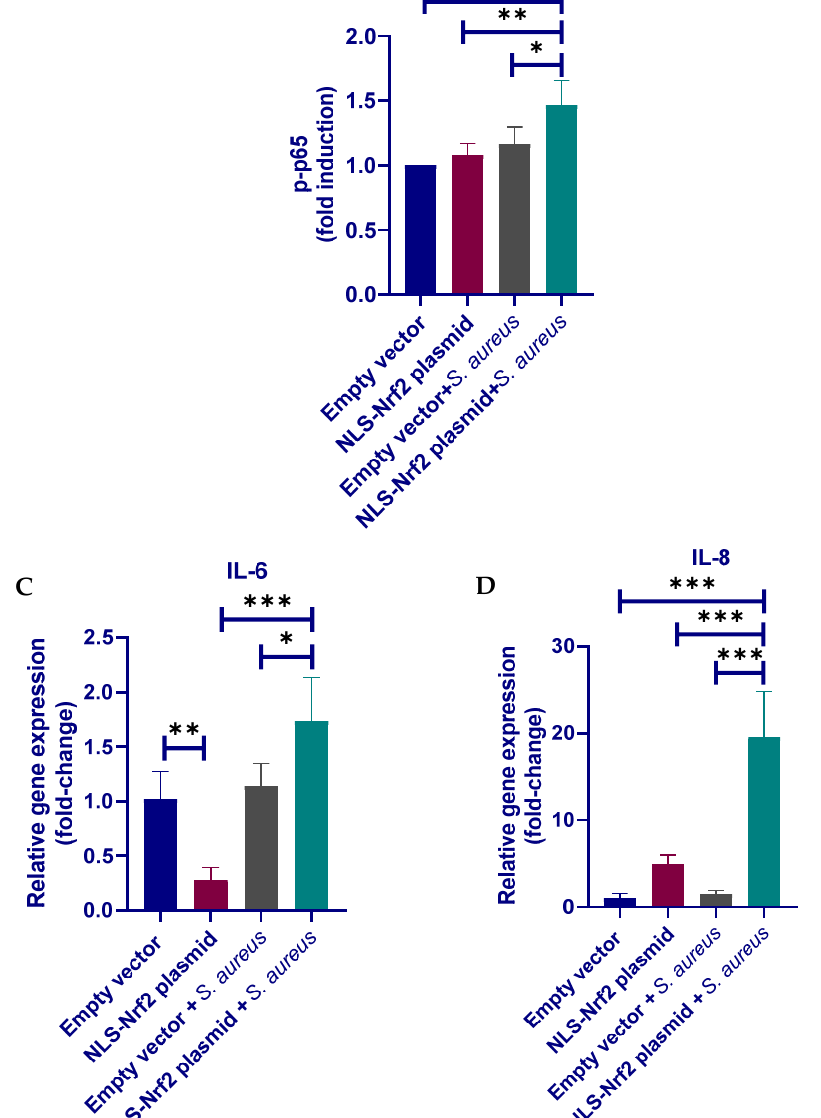
Figure 7. Evaluation of Nrf2 overexpression on the inflammatory responses of pbMECs to S. aureus . ( A ) Confirmation of Nrf2 overexpression. Cells were transfected with a GFP-expressing Nrf2 plasmid containing tripartite nuclear localization signal (NLS-Nrf2) for 24 h. GFP fluorescence was determined under a microscope and whole-cell extracts were analyzed by immunoblotting with anti-GFP. ( B ) Evaluation of the effect of Nrf2 overexpression on NF- κ B p65 activation in response to S. aureus . The cells transfected with GFP-expressing Nrf2 plasmid were incubated with S. aureus for 6 h. Whole-cell extracts were analyzed by immunoblotting with anti-phospho NF- κ B p65 antibody (p-p65). β -actin was used for the equal loading control. p-p65 levels were determined with densitometry analyses after normalization to Actin. Bars are means ± s.d. of three triplicates and are representative of 3 separate experiments. ( C , D ) Evaluation of the effect of Nrf2 overexpression on the expression of pro-inflammatory cytokines was induced by S. aureus . The cells transfected with GFP-expressing Nrf2 plasmid were incubated with S. aureus for 6 h. Total RNAs were prepared and subjected to qPCR analyses for the mRNA levels of IL-6 and IL-8 . The results are the mean ± s.d. of three replicates and are representative of 3 separate experiments ( D ). * p < 0.05, ** p < 0.01 and *** p < 0.001.